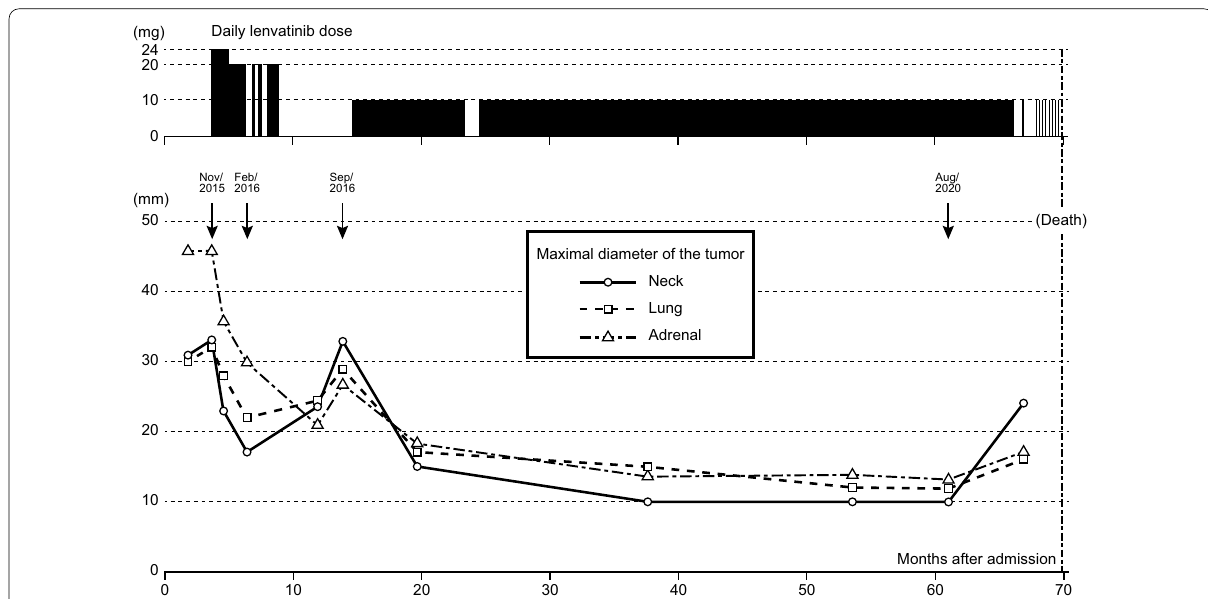
Fig. 1 A series of measurable tumor sizes and lenvatinib doses over time. Lenvatinib dose and duration of treatment are shown in the upper part of the graph (black boxes). The size of the three measurable sites (neck: pre-laryngeal lymph node, lung: largest mass in the right lobe, adrenal: left) are represented by dashed or solid lines with open circles, boxes, and triangles, respectively. Four arrows indicate the dates of computed tomography (CT) scans shown in Fig.